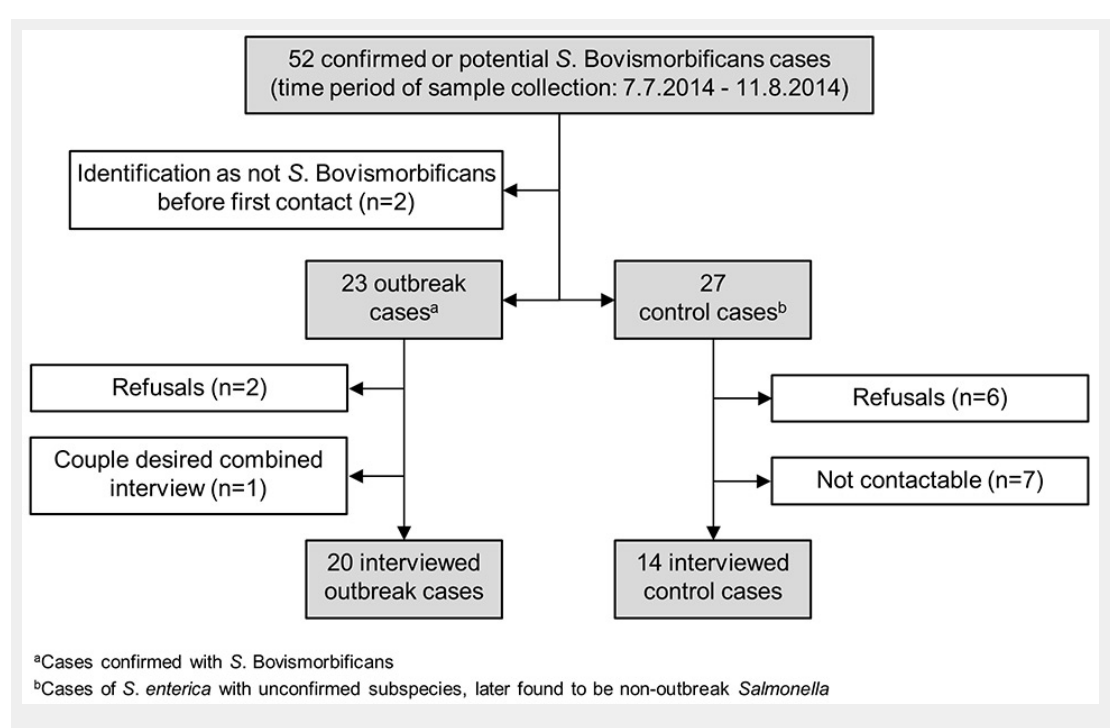
Participation in the Salmonella Bovismorbificans outbreak investigation, July–August 2014,